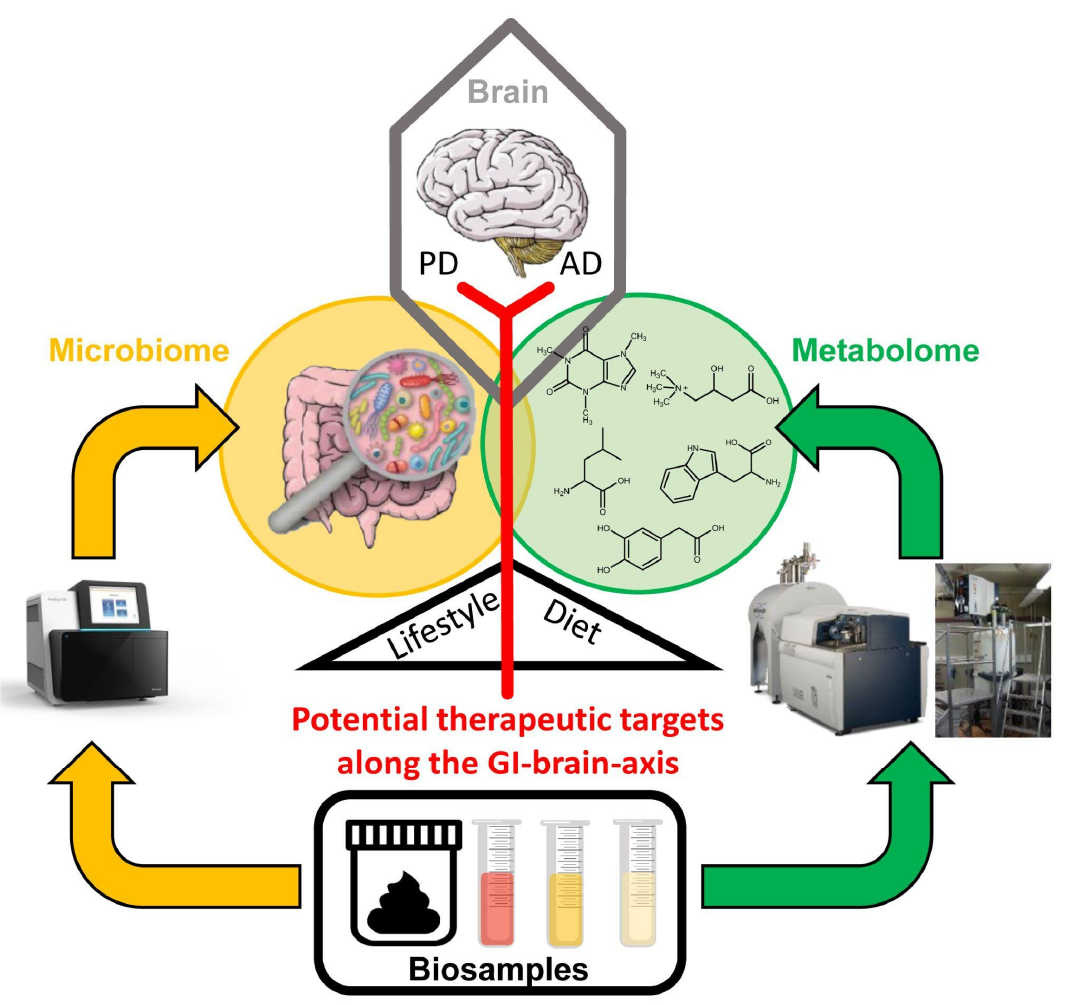
Figure 1. Schematic illustration of the gastrointestinal (GI)–brain axis (red) that could be modulated via potential therapeutic targets involving indirect (lifestyle/diet) and direct modulation of the microbiome (orange circle) and metabolome (green circle). Such therapeutic modulation of the GI-brain axis may represent a promising strategy for the early prevention of neurodegenerative processes in Parkinson’s and Alzheimer’s disease. Further research and analyses of biosamples regarding the microbiome and metabolome are needed and facilitated by methodological advances: sequencing allows the taxonomic and functional characterization of the microbiome (orange arrows) of stool samples of the gut and biospecimens from various other body sites. Metabolomics (green arrows) is facilitated by mass spectrometry (left) or nuclear magnetic resonance spectroscopy (right).